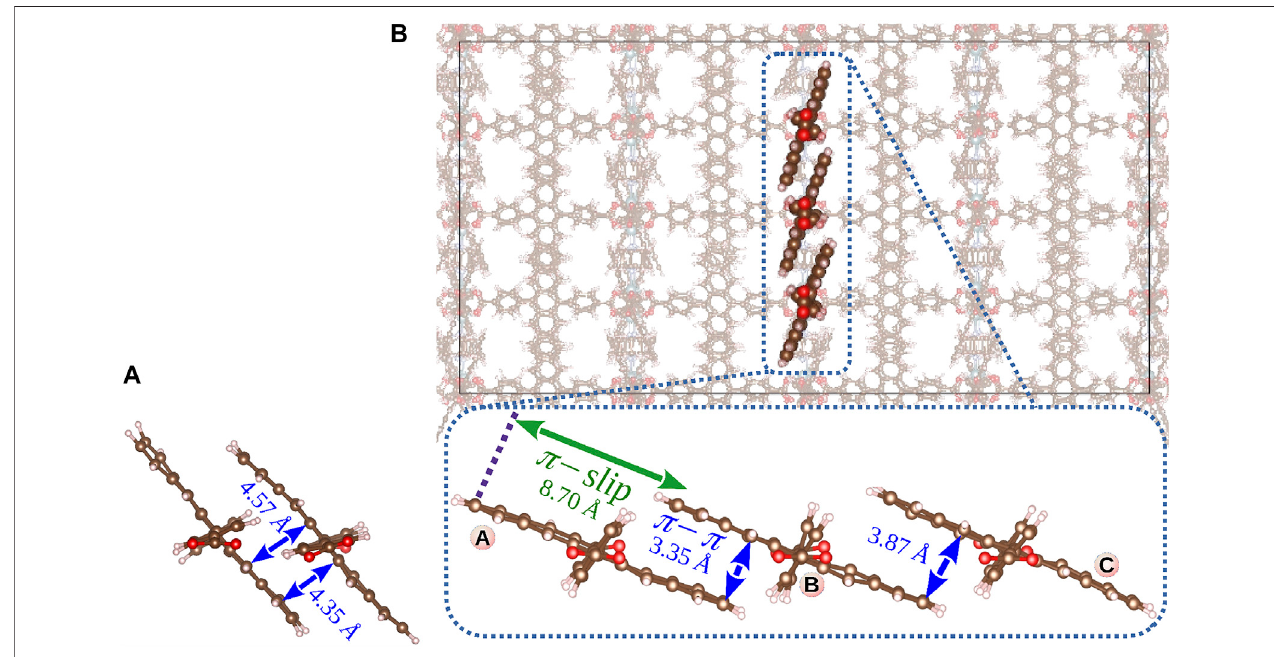
FIGURE7| MolecularpackingofthepentacenecoresinaMOFasafunctionofMOFtopologyandtheCOMdistancebetweenditopiclinkers:dimerstructurefrom QM/MM MD simulation of Zn paddlewheel SURMOF-2 reported by Haldar et al. (2021) (COM of 5.8 Å) (A) . Cu 2 (Pn) 2 (DABCO) PCU-type MOF simulated in the present study and the trimer of layer linkers formed during MD simulation at 298 K (COM of 9.2 Å) (B)